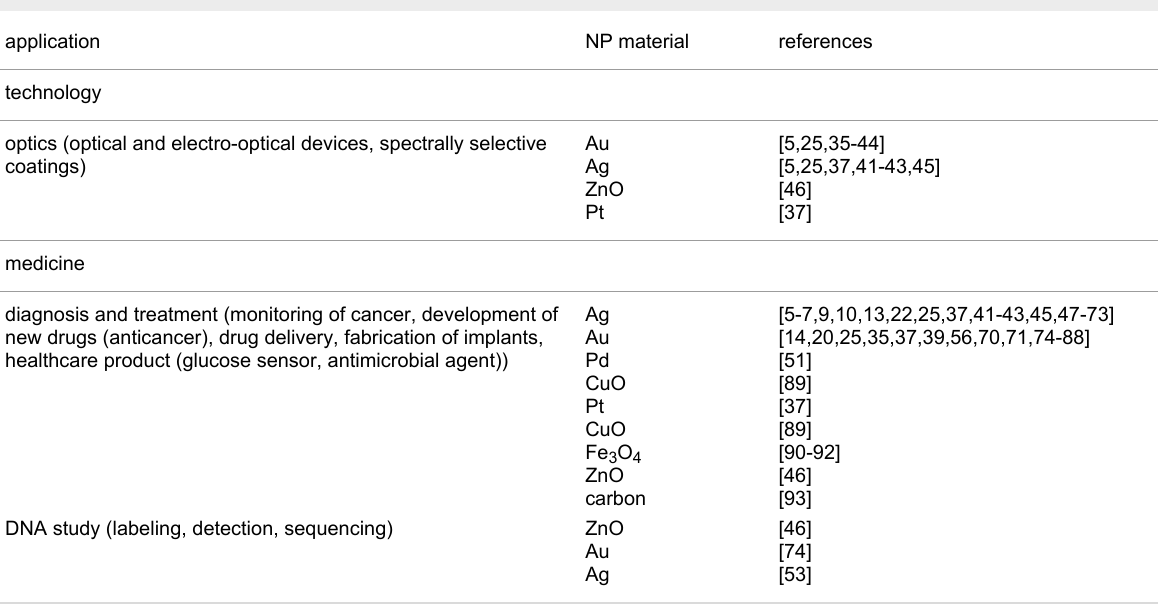
Table 1: Applications of nanotechnology in different